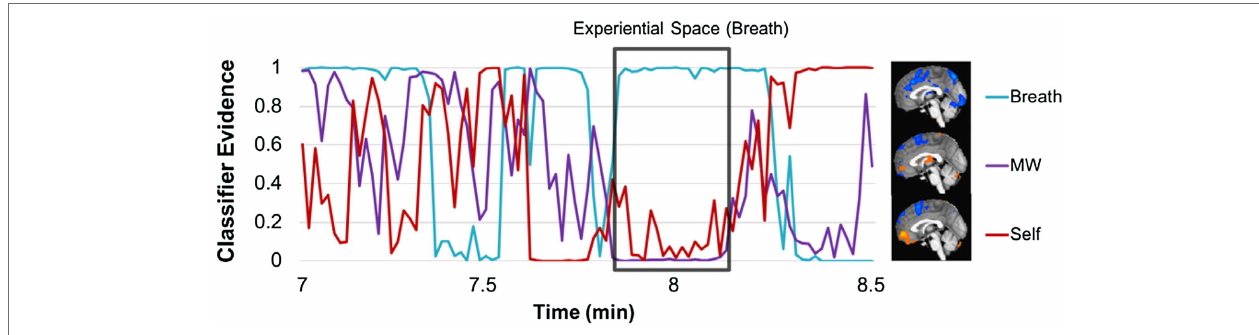
FIGURE 2 | Initial empirical evidence of experiential space during mindful attention to the